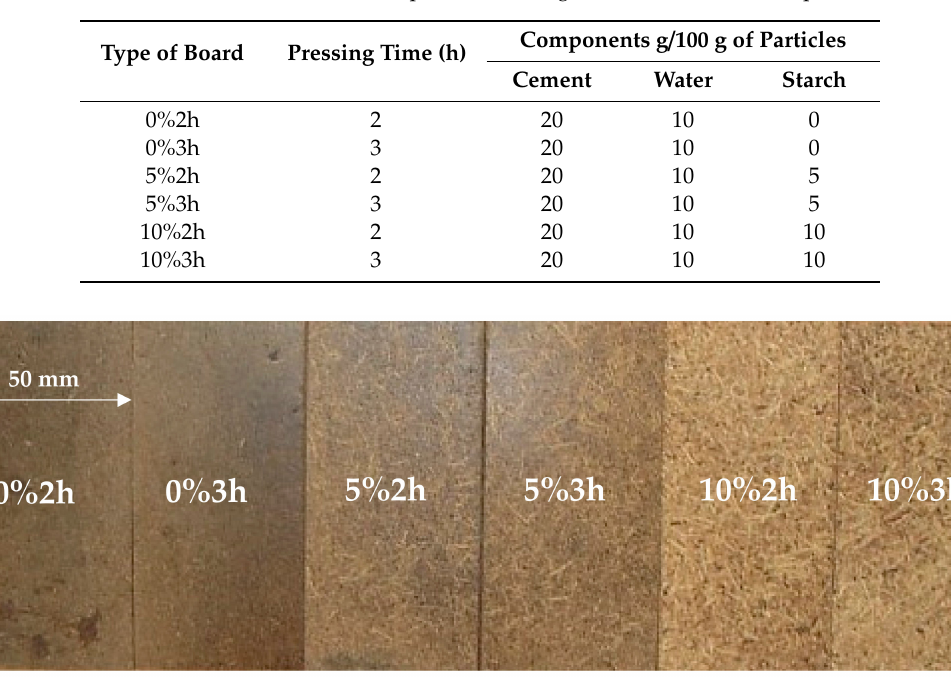
Table 1. Characteristics and composition in weight of the manufactured panels.